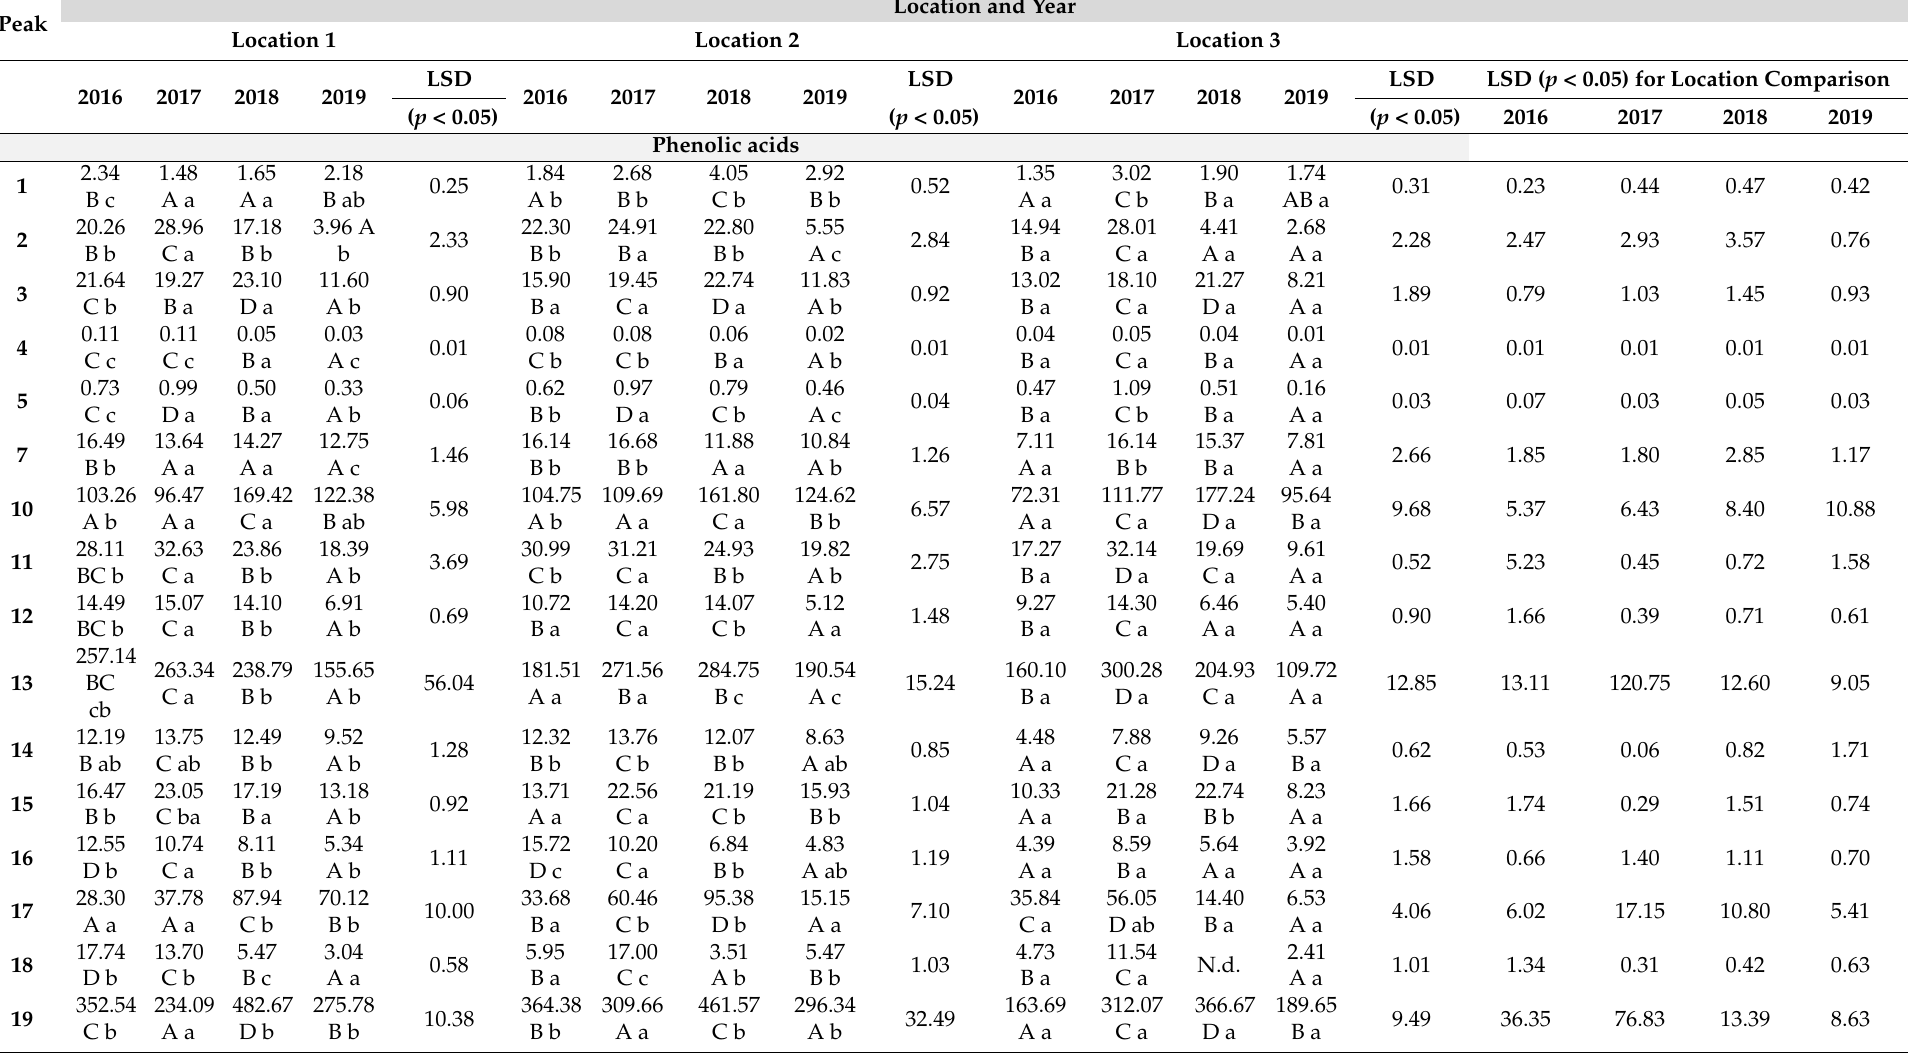
Table 3. Quantitative (poly)phenolic profile (mg/100g fw) of Prunus lusitanica fruits grown under different agroclimatic conditions (locations and